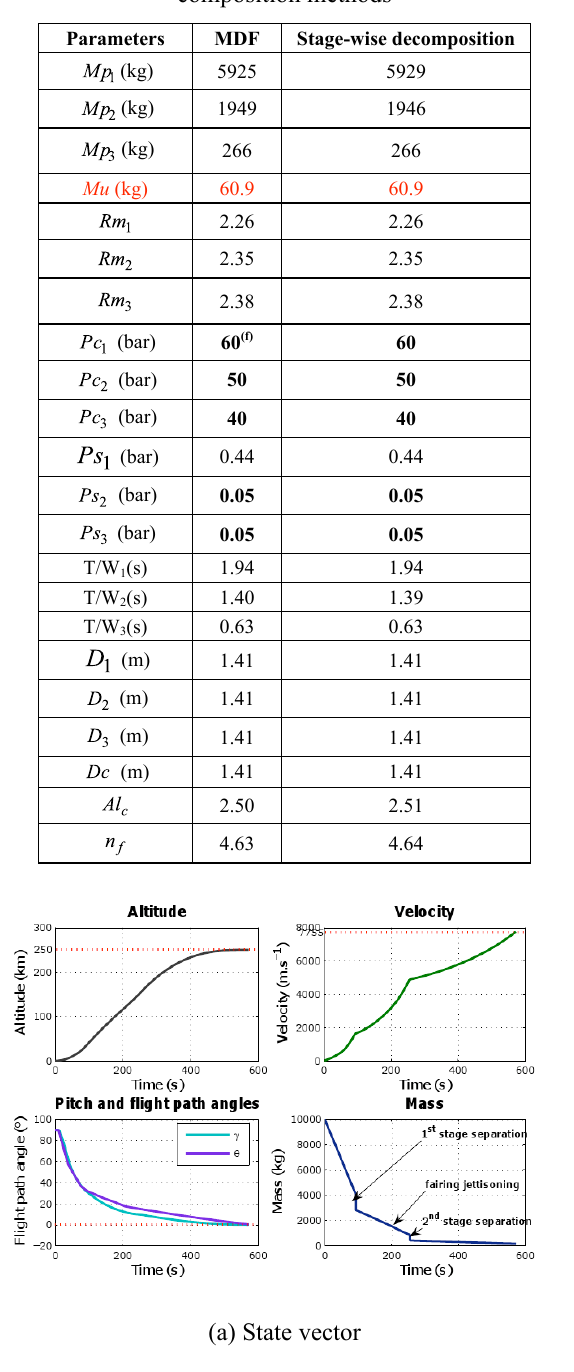
Table 3. Results obtained by using MDO and stage-wise de- composition